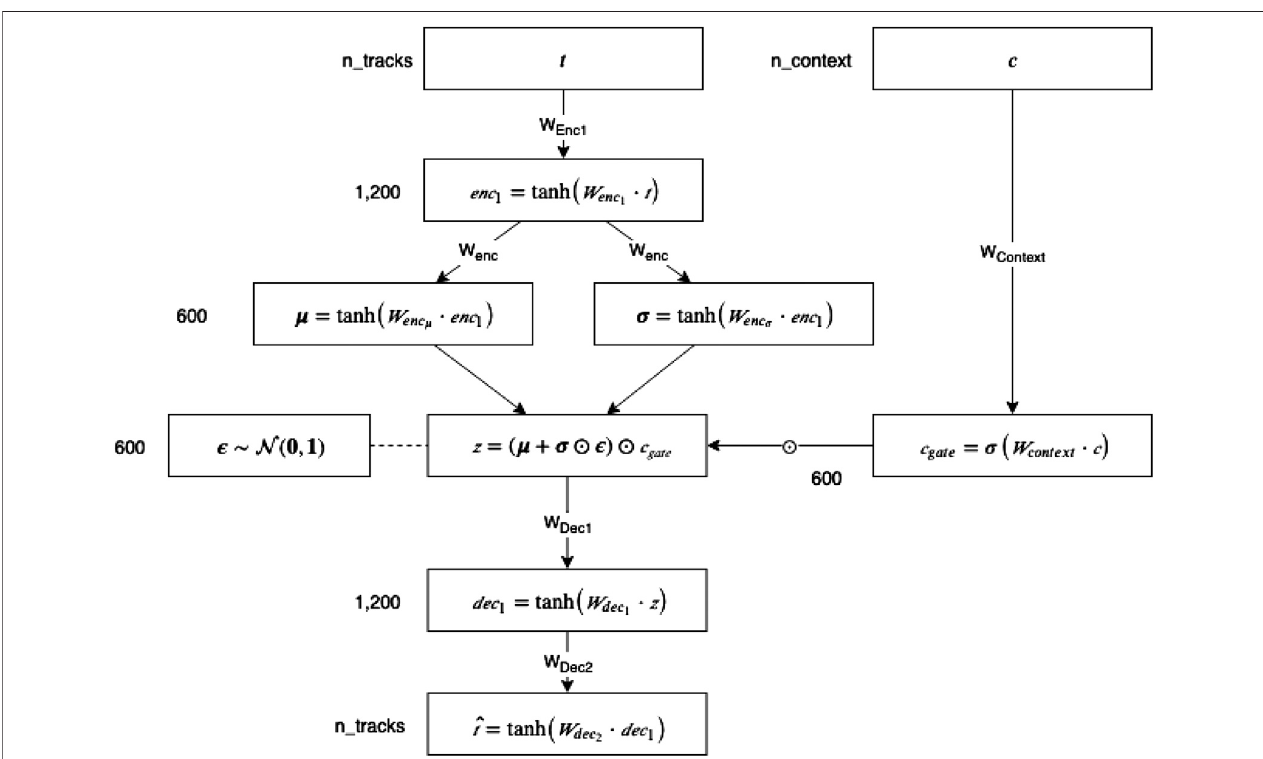
FIGURE 7 | Architecture of the variational autoencoder with gated context information.